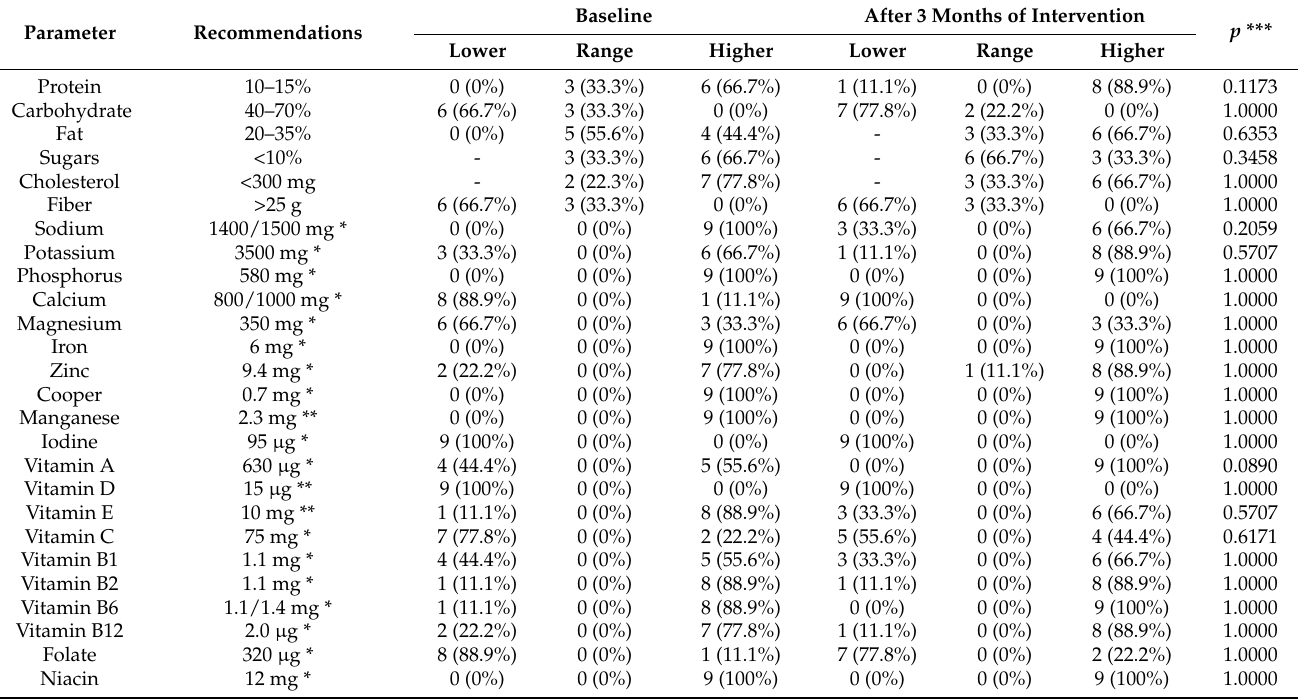
Table 7. The nutritional value of the diet compared with the recommended values depending on the age of the male participants at baseline and after 3 months of intervention.